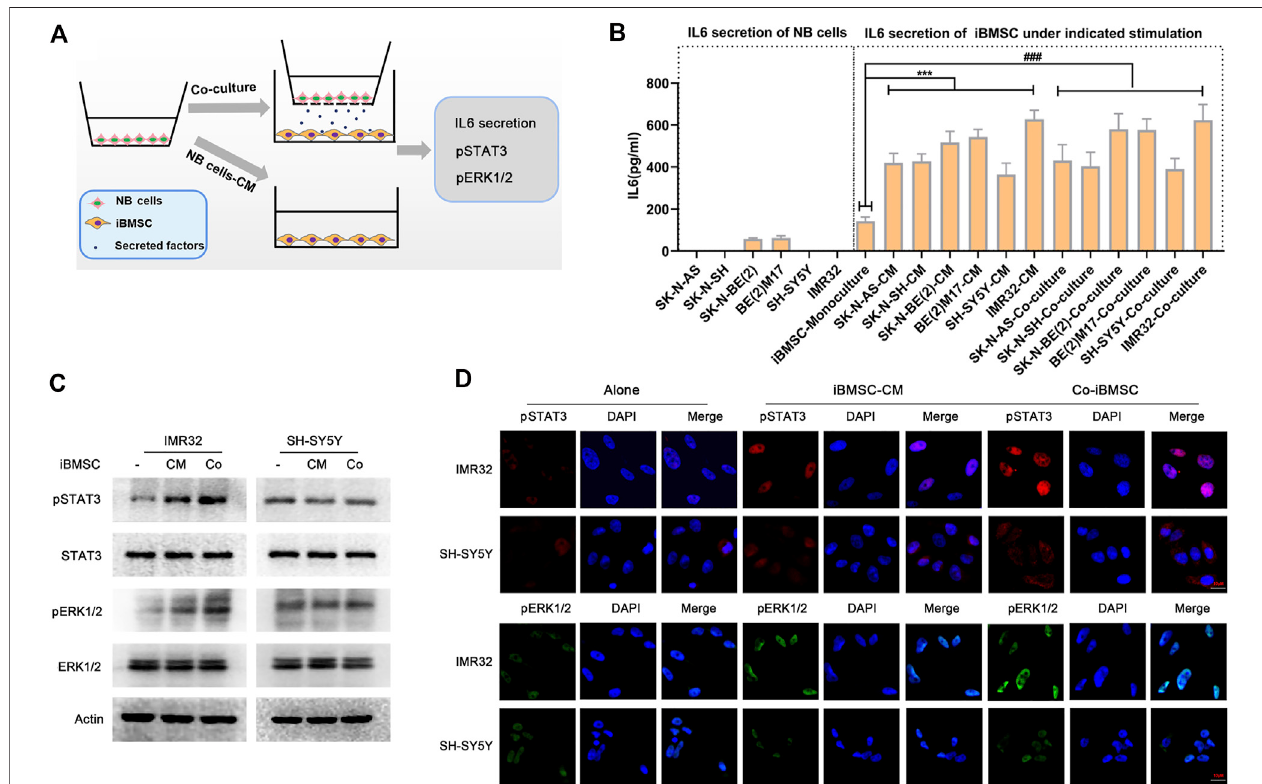
FIGURE 2 | NB cells stimulated IL6 secretion from bone marrow mesenchymal stem cells. (A) Schematic diagram of iBMSC stimulated with NB cells CM or co- culturedwithNBcells.Thatis,iBMSCwereculturedwithCMderivedfrom6NBcellsorco-culturedwithNBcellsfor48 h. (B) ThecontentofIL6wasdetected byELISA in the supernatant of the corresponding culture system. NB cells were co-culture with iBMSC or stimulated by NB cells-priming iBMSC CM. (C) The protein expression levels of pSTAT3, STAT3, pERK1/2 and ERK1/2 in NB cells were detected by WB. (D) The phosphorylation levels and localization of pSTAT3 and pERK1/2 in NBcellsweredetectedbyimmuno fl uorescence.Datarepresentsthreeindependentexperimentsandispresentedasmean ± SD( ***p <